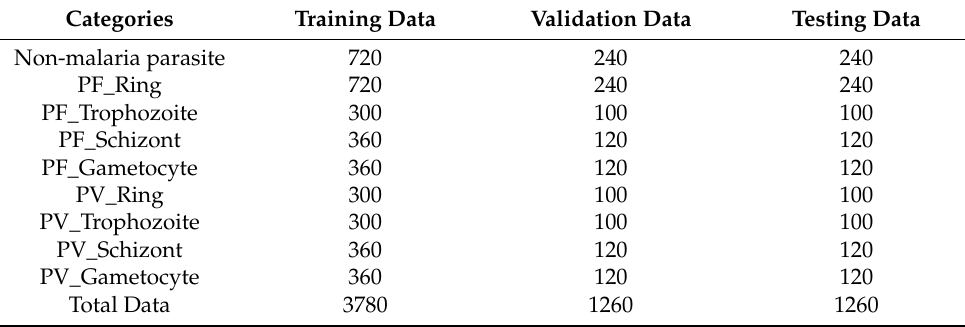
Table 2. Training, validation, and testing data distributions for the thin